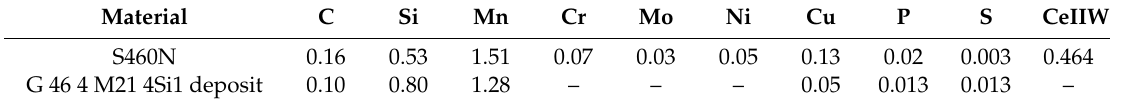
Table 1. The chemical composition of the used materials, wt.%.